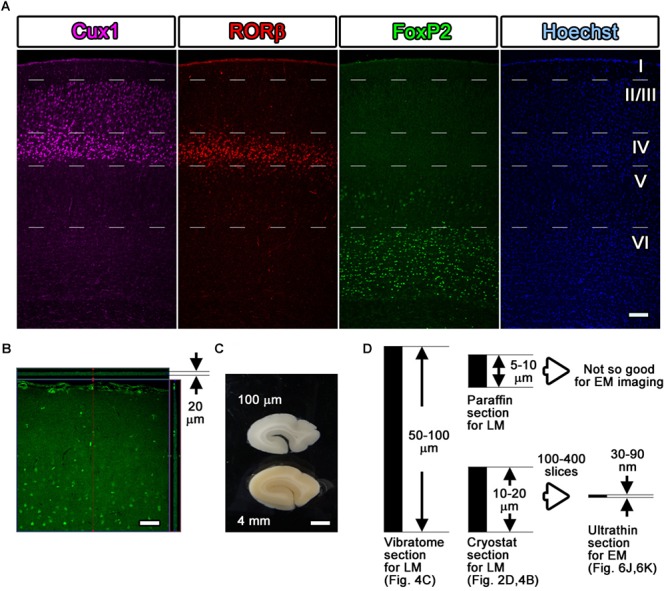
Fluorescence images with layer markers. (A) Multicolor fluorescence images were obtained from immunostained mouse brain samples using a confocal laser scanning microscope. Mouse somatosensory cerebral cortex sections were stained with antibodies recognizing Cux1 (magenta, mainly layer II–IV), RORβ (red, mainly layer IV), and FoxP2 (green, mainly layer VI) and with Hoechst dye (blue, nucleus). The white dotted lines indicate the estimated border of each layer. (B) An immunostained section was observed by LM, and the thickness and the depth of infiltration by the antibody were evaluated. The full thickness of 20 μm was completely infiltrated with the green-labeled secondary antibody, reflecting the Cux1 localization. (C) Floating sections 100 μm thick were prepared from a dissected marmoset brain using a vibratome. The floating sections were frequently used for fluorescence immunostaining of large sections. (D) Summary of the thickness of the sections. Vibratome slices and cryostat sections can be transferred for use in CLEM imaging, but the floating sections from the vibratome are too thick to be infiltrated to their full depth. Scale bars: (A)–(B) 100 μm, (C) 2 mm.